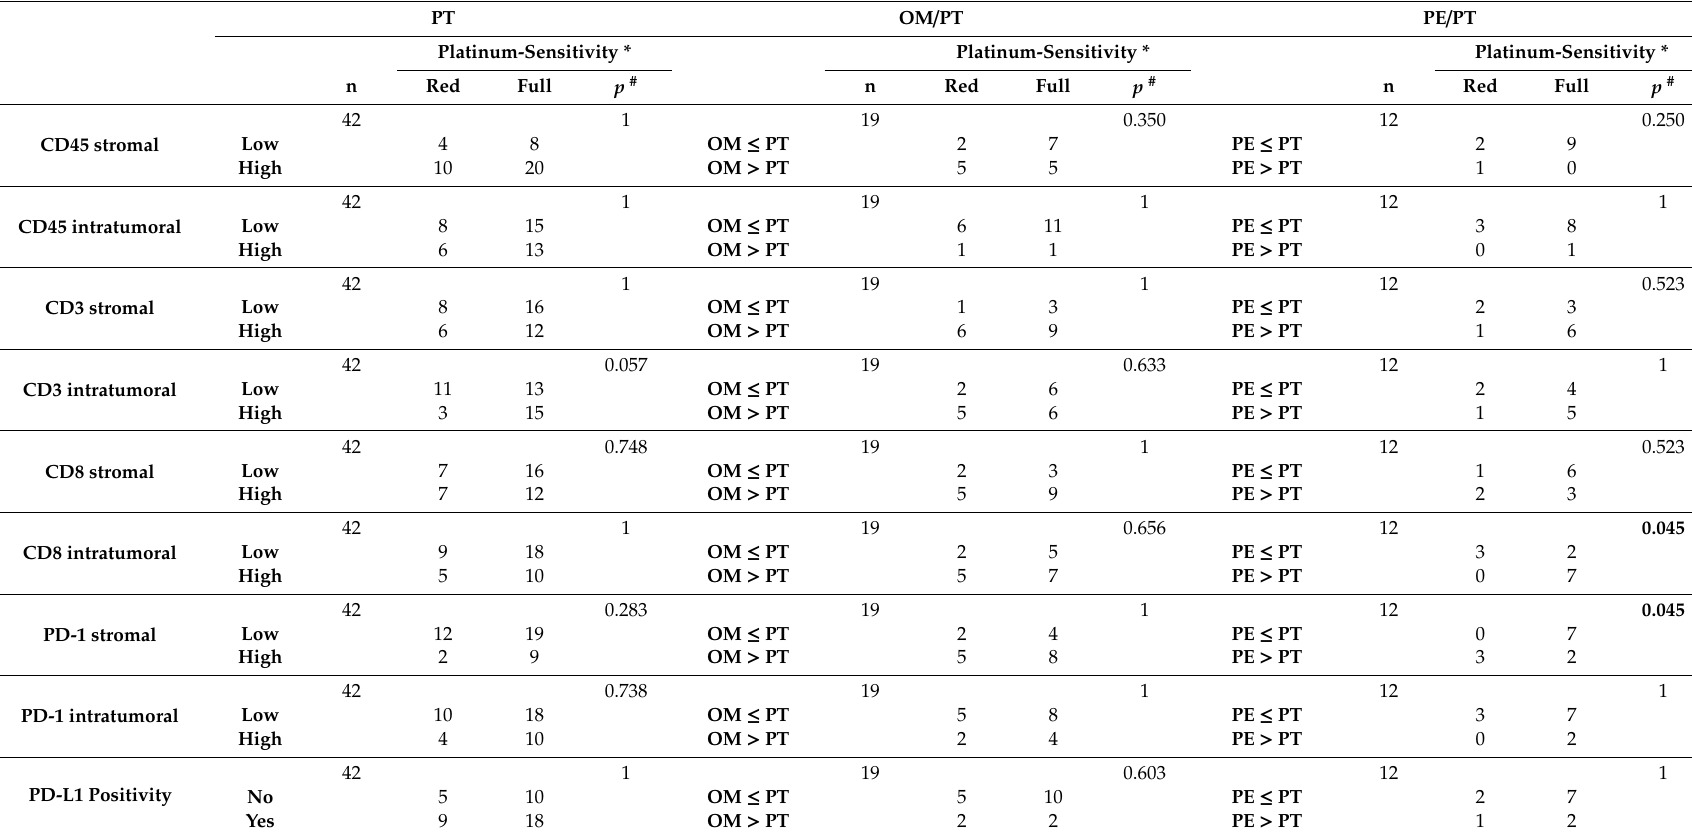
Table 3. Immune cell phenotypes of primary tumor and corresponding lesions in relation to